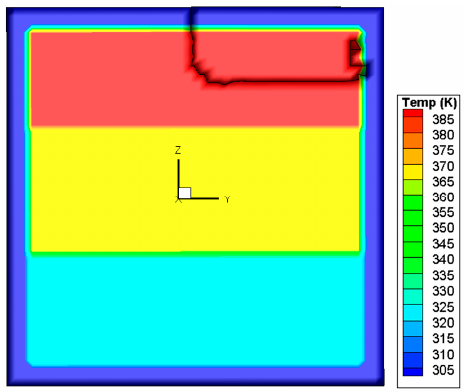
Figure 18. Crack path predicted by the criterion based on maximum principal stress.